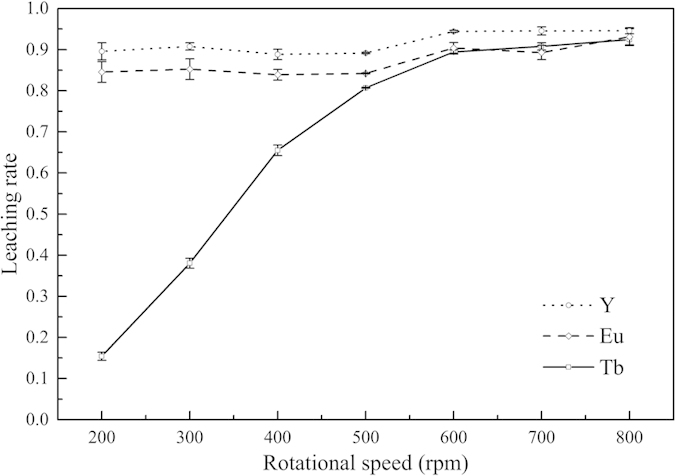
Leaching rate of selected REEs Tb, Eu, and Y dissolved from phosphors activated at different rotational speeds.Error bars represent the standard error of the mean for three replicates.